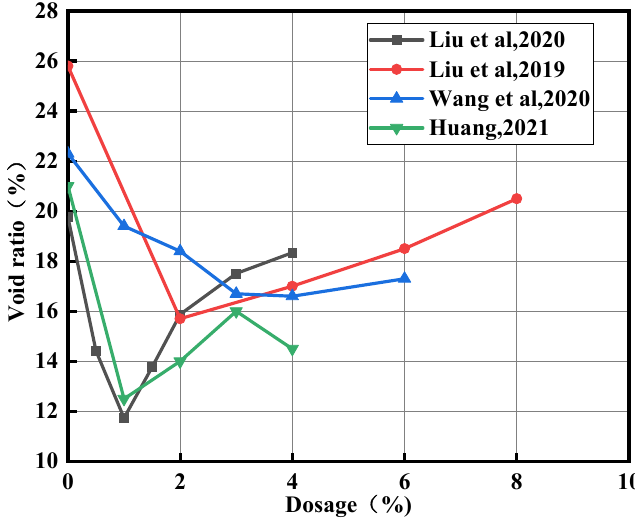
Figure 7. Variation of void ratio with lignosulfonate [24,48,50,52].